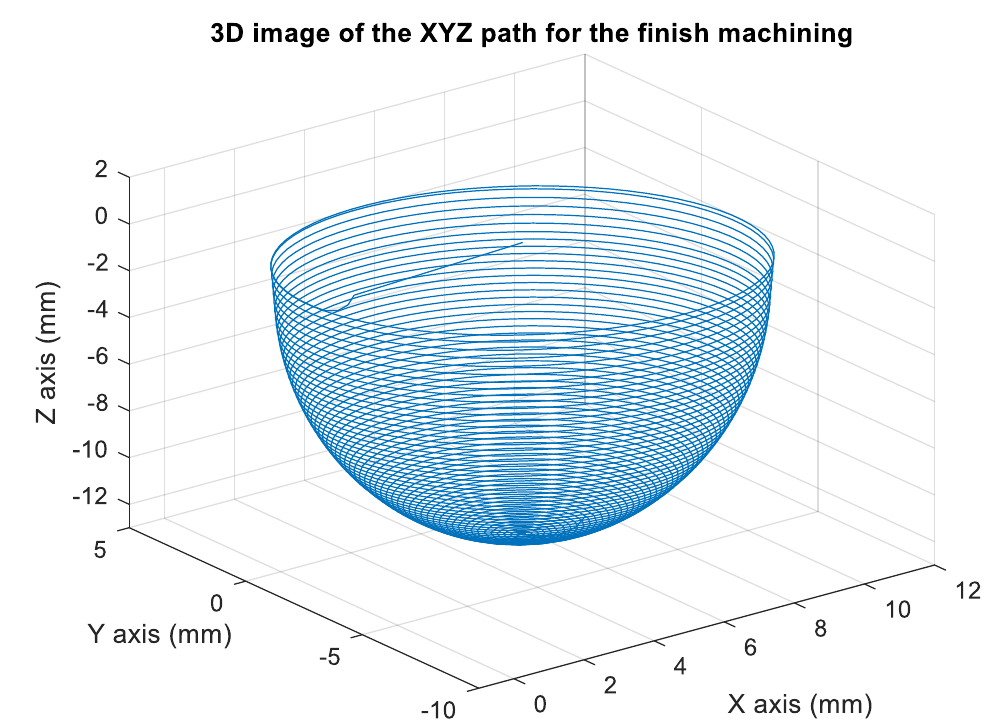
Figure 24. Three-dimensional image of the XYZ path after converting the finish machining program.